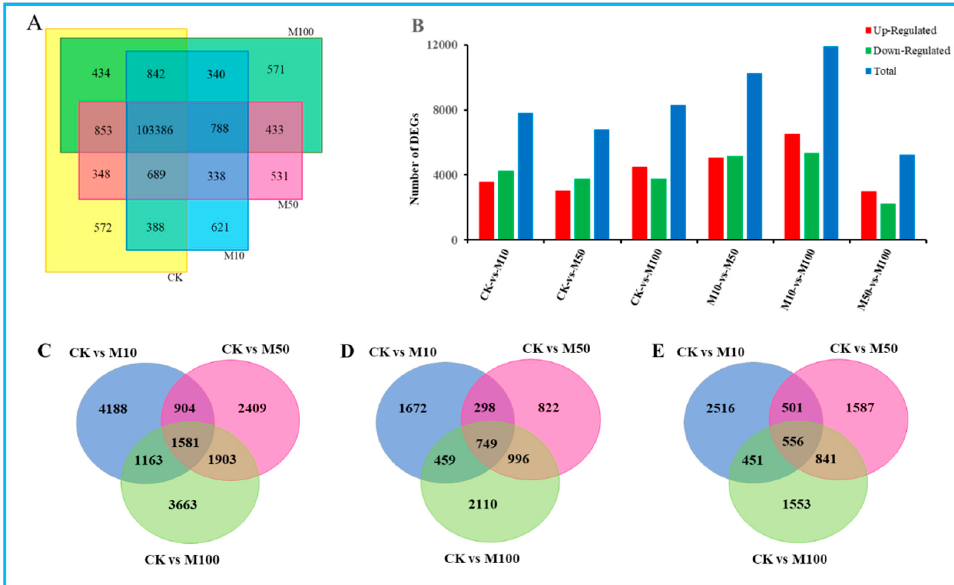
Figure 2. Statistical analysis of differentially expressed unigenes in rosemary suspension cells under different concentrations of MeJA. ( A ) The Venn diagram of expressed genes in four MeJA treatments. ( B ) statistic of up/down-regulated genes in pairwise comparisons. ( C ) Venn diagram of DEGs under MeJA treatment. ( D ) Venn diagram of the unique and common regulated DEGs up-regulated of DEGs under MeJA treatments. ( E ) Venn diagram of the unique and common regulated DEGs down-regulated of DEGs under MeJA treatments.